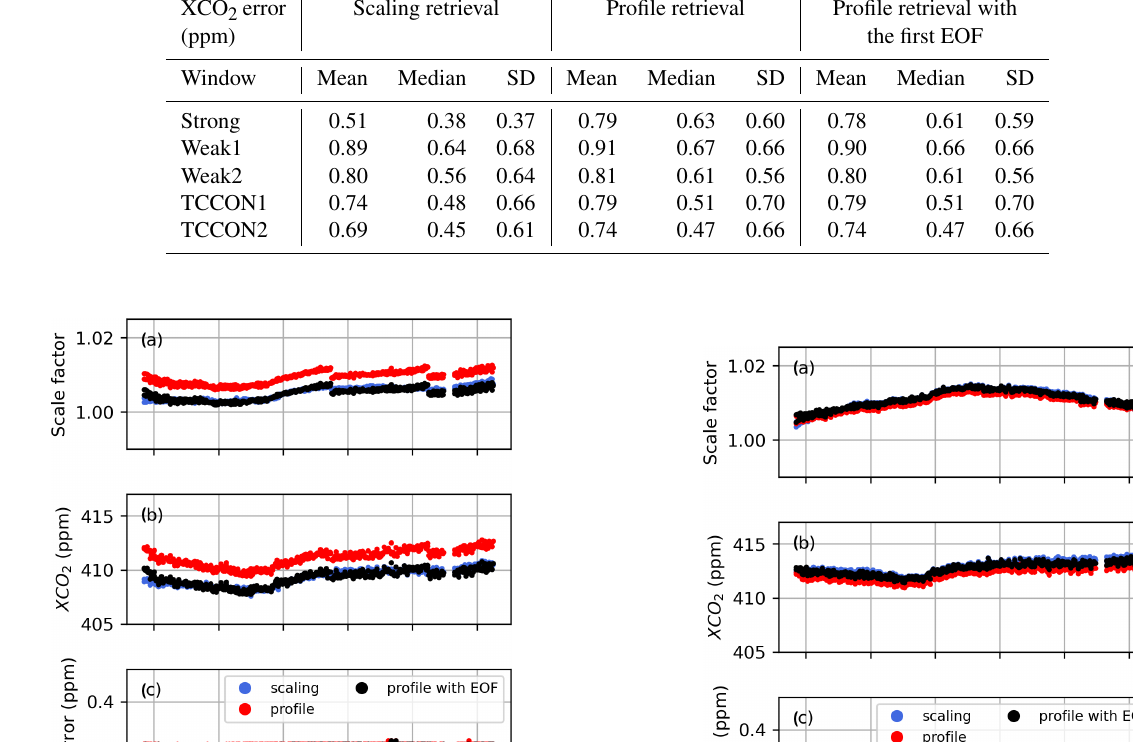
Table E1. Statistics on the retrieved XCO 2 error for one year of measurements at the East Trout Lake TCCON station. “SD” indicates the standard deviation. Scaling retrieval Profile retrieval Profile retrieval with